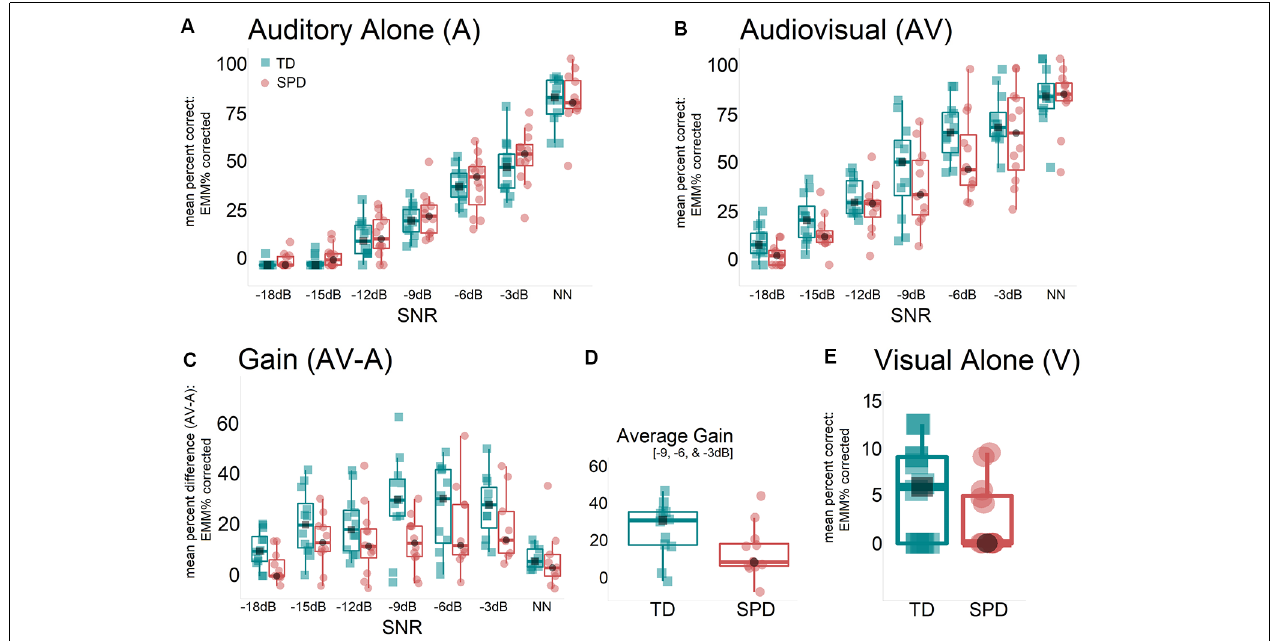
FIGURE 1 | (A) Performance in the auditory alone condition does not differ between sensory processing disorder (SPD) and typically developing (TD) children. (B) Performance in the audiovisual condition shows a numerical decrease in performance for the SPD children, but this does not reach significance. (C) Considering the difference between audiovisual performance and auditory alone performance (i.e., how much multisensory gain is achieved), a clear difference between groups emerges with SPD children showing significantly less gain than is seen in TD children. (D) This panel shows the average performance across the three noise levels showing the greatest difference between groups ( − 9, − 6, and − 3 dB). The average gain across these three SNR levels is 24.7% in the TD group, compared to 12.6% in the SPD cohort. (E) The performance of both TD and SPD children is poor in the visual-alone condition (i.e., lip-reading). There is no significant difference between groups. Note that in all panels estimated marginal means are illustrated, indicating the adjustment in the model for the age covariate.